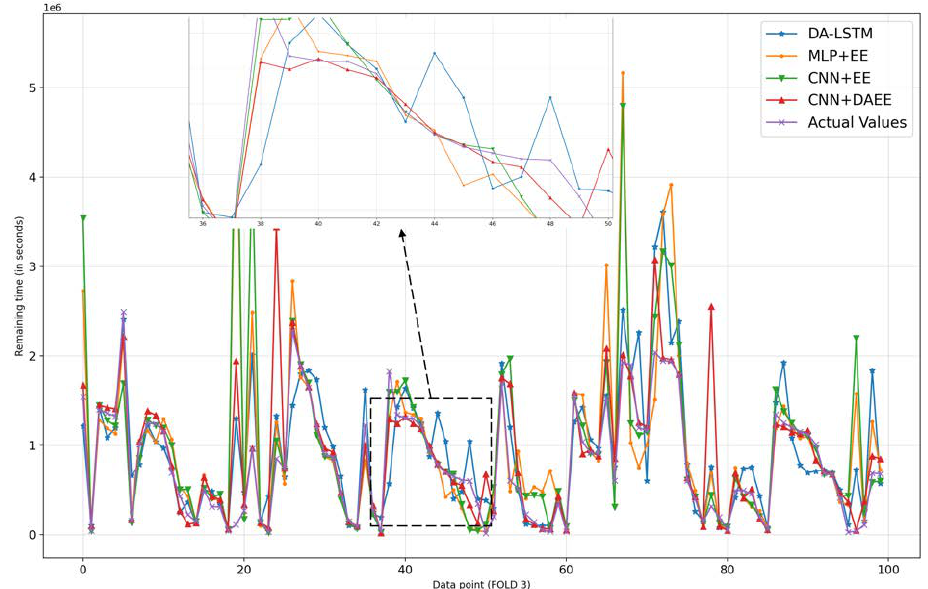
Figure 8. Comparison of results of four models for 100 sample test sets in second iteration of CV.